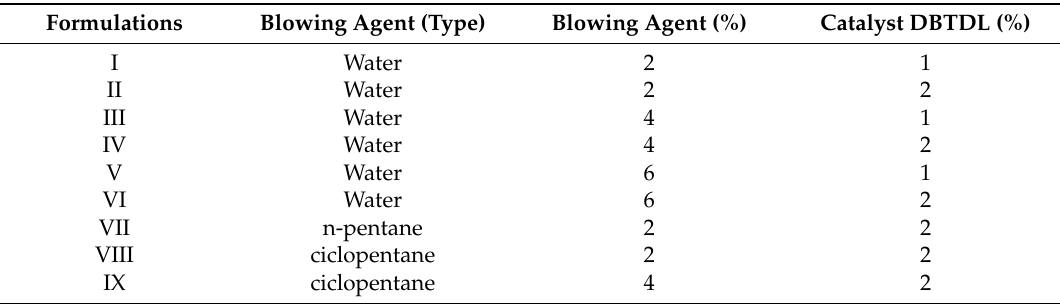
Table 1. Formulations of the foams prepared with GCo polyol (10% crude glycerol and 90% castor